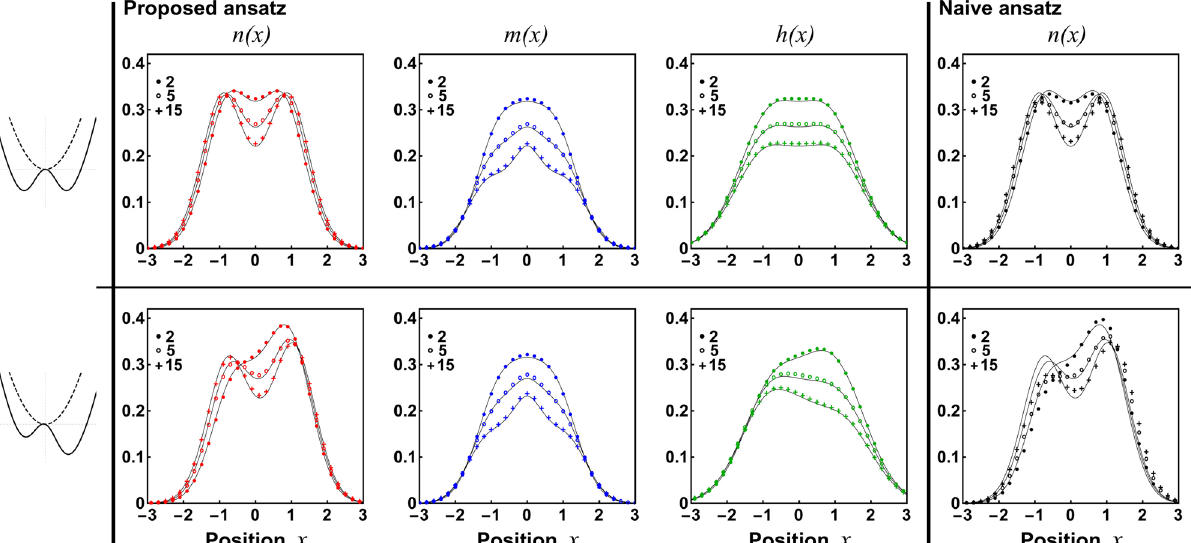
2 bosons confined Figure 1. Different cuts of the reduced single-particle density matrix for the system of N = in different traps and with different interactions as predicted by the ansatz (different colour symbols) and compared with numerically exact results (solid lines). Consecutive columns present: the density profile n ( x ), the anti-diagonal part m ( x ), and the horizontal cut h ( x ). Note almost perfect agreement between the ansatz’s predictions and the exact results in a whole range of interactions as well as for traps of different symmetries. For comparison, in the last column we display the single-particle density profile n ( x ) predicted by the naive x y . In this case, significant deviations from the exact results (solid lines) are clearly ansatz with D β ( x , y ) = − 1.0 , δ 0.5 and the asymmetry ξ 0.0 and ξ 0.2 , visible. The two traps considered are characterized by (cid:31) = = = =